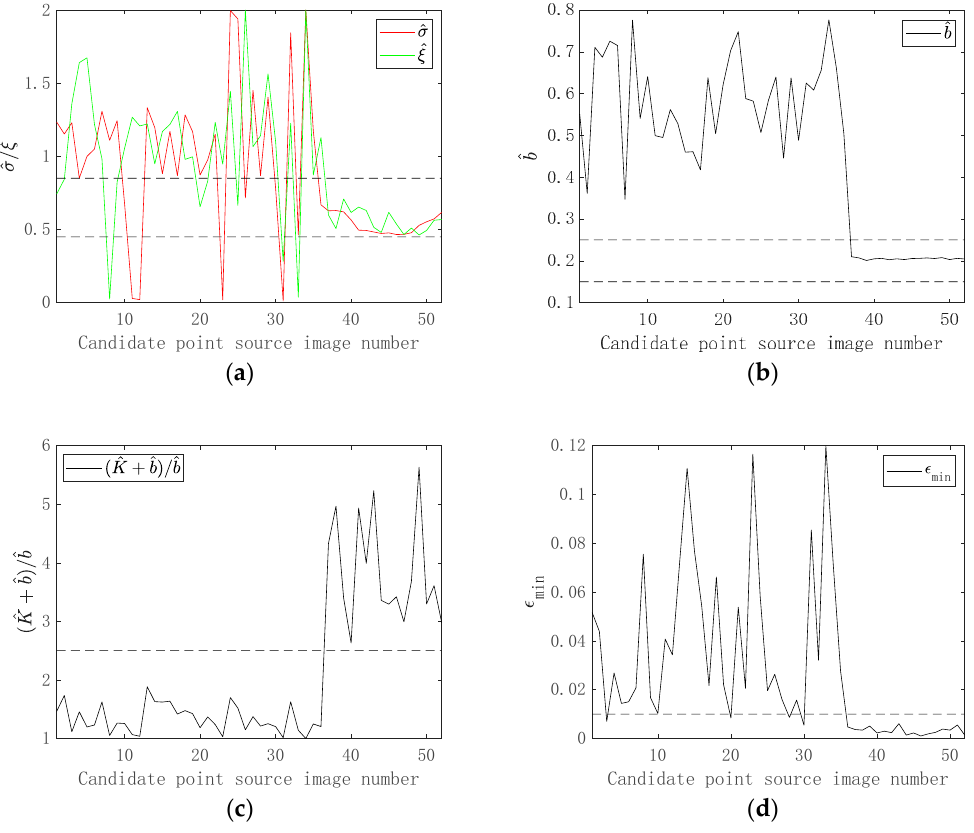
Figure 9. Curve of feature parameters as a function of candidate point source image number. ( a – d ) correspond to ˆ σ and ˆ ξ , ˆ b , ( ˆ K + ˆ b ) /ˆ b , and ε min ,